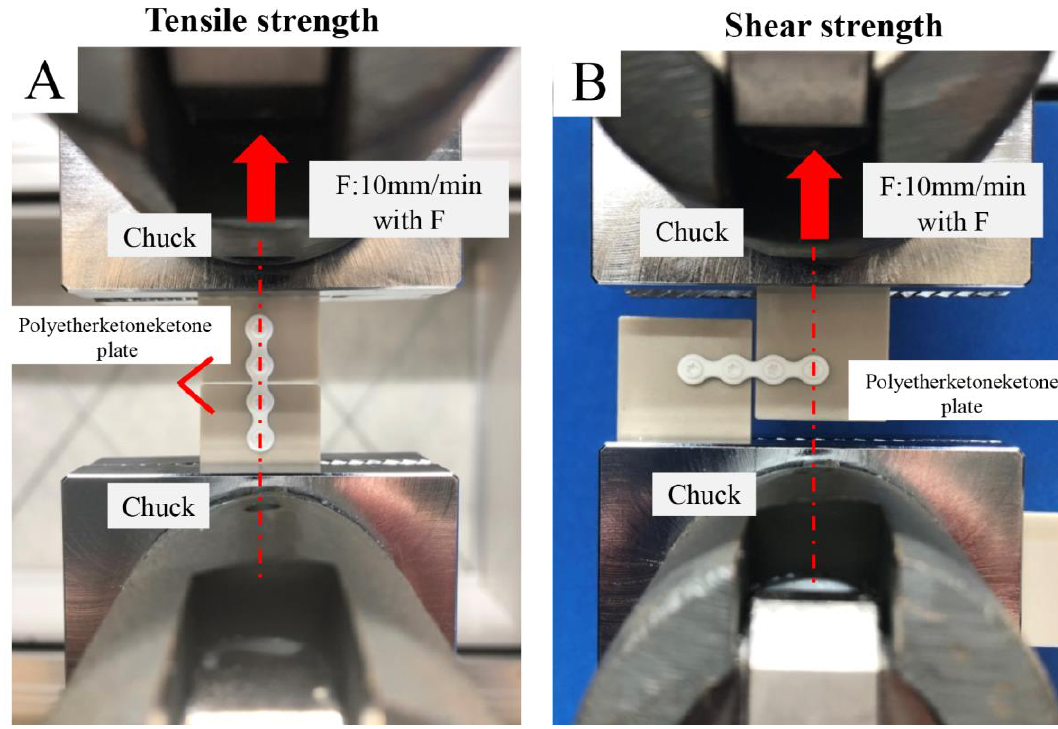
Figure 1. Mechanical strength models were prepared by fixing the plate with screws to the polyetherketoneketone plate. ( A ) Tensile strength; ( B ) shear strength.